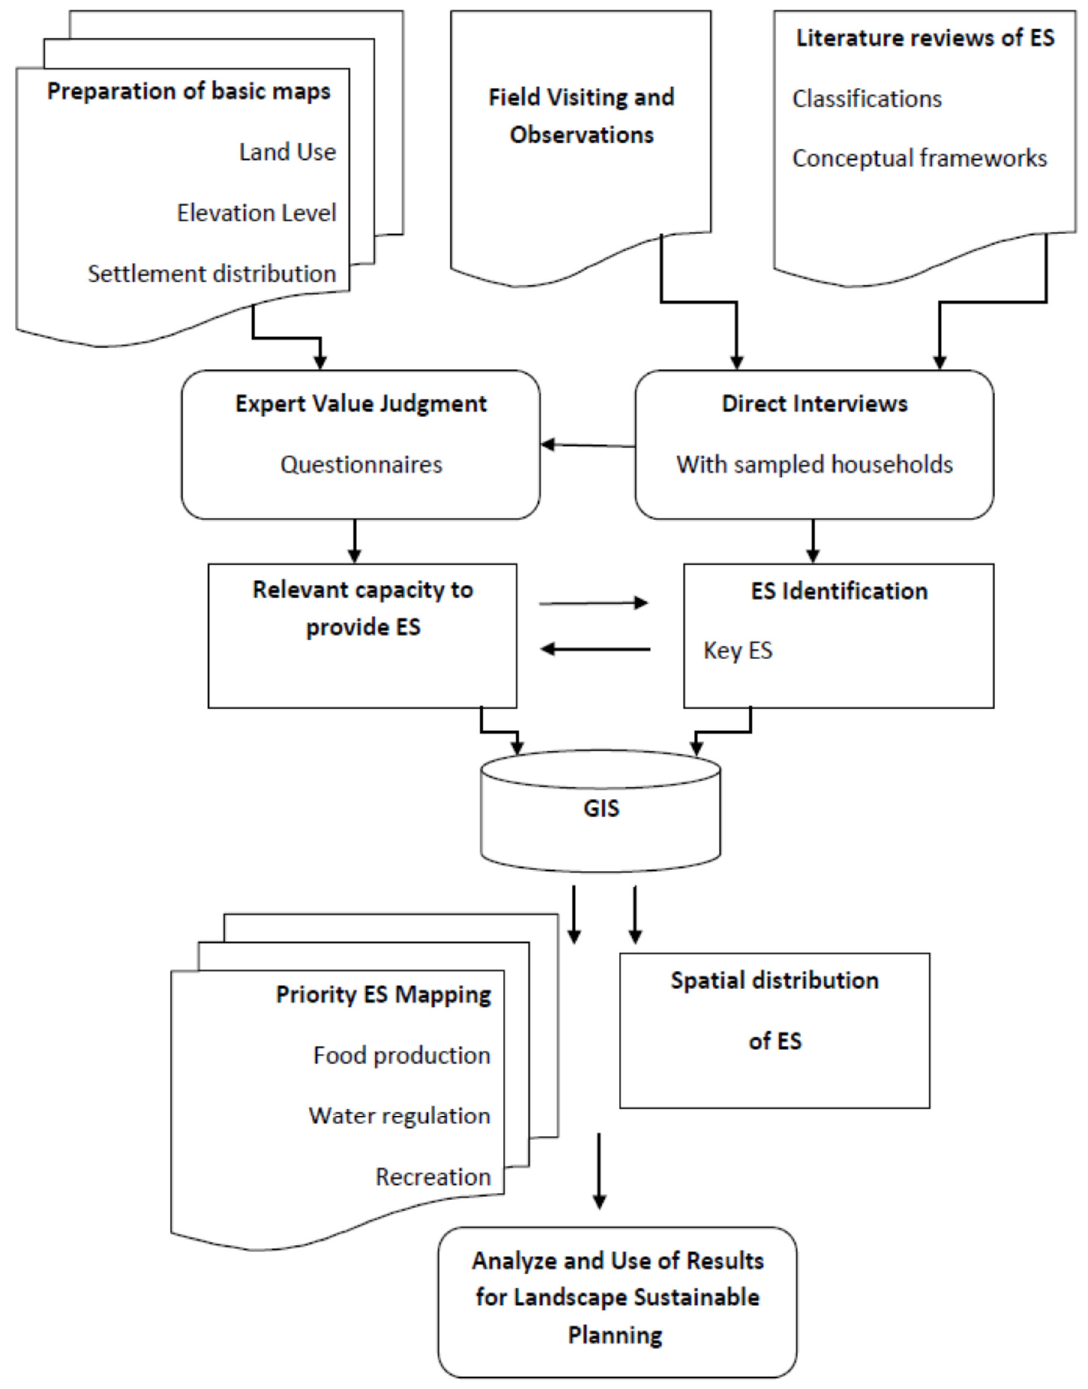
Figure 2. Practical approach of qualitative rapid assessment of Ecosystem Services (ES) in the study